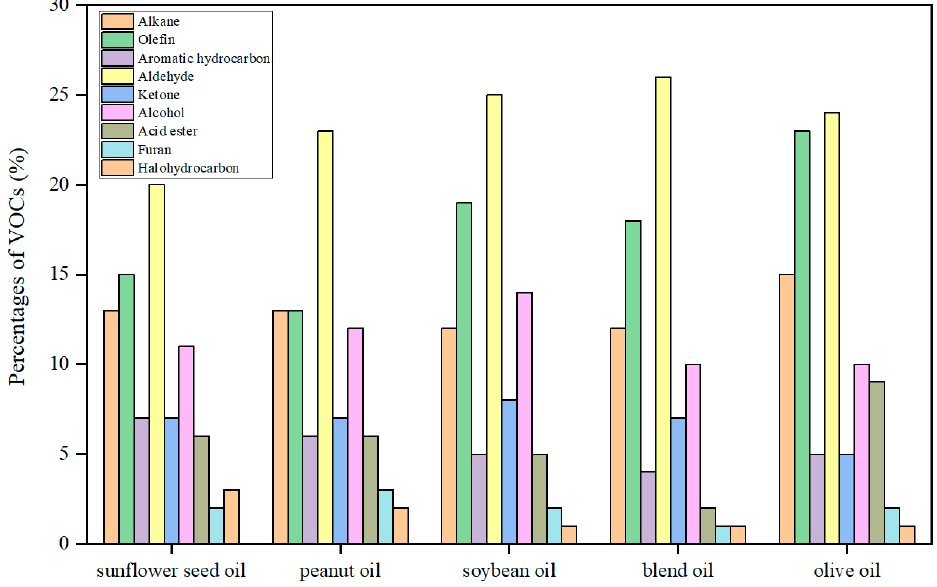
Figure 1. Distribution of VOCs in different cooking oils at 260 °C [34].